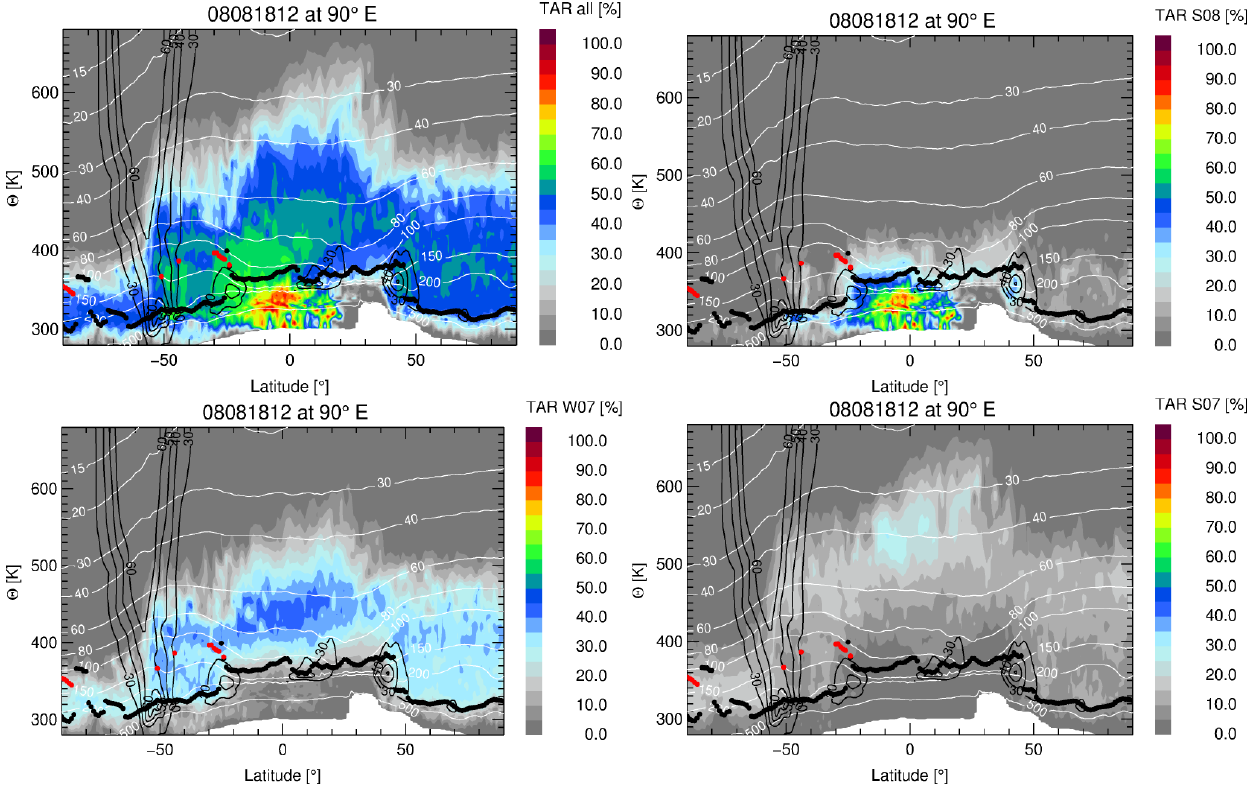
Figure 10. As Fig. 9 but for the fraction of the tracer for tropical adjacent regions (TAR).